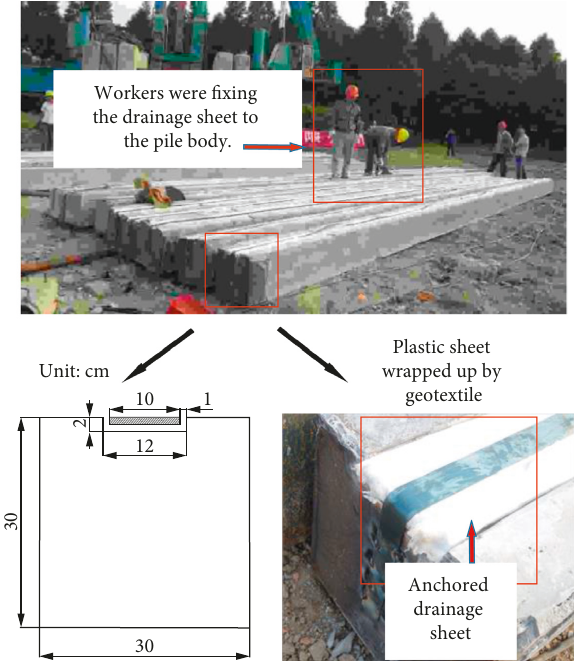
Figure 2: Cross section of the rigid-drainage pile.